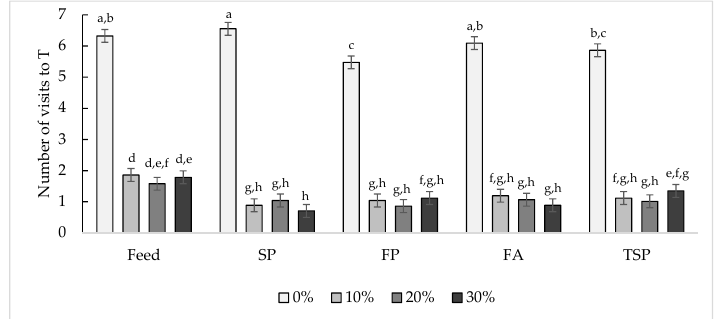
Figure 5. E ff ect of door weight (0%, 10%, 20%, 30%) and resource (feed, soiled pine and spruce wood shavings (SP), fresh pine and spruce wood shavings (FP), fresh aspen wood shavings (FA), ammonia reductant treated soiled pine and spruce wood shavings (TSP)) on the mean number of visits ( ± SEM) into the treatment compartment over a period of 13.5 h per day. Bars with di ff erent letters display significant di ff erences ( p < 0.05).